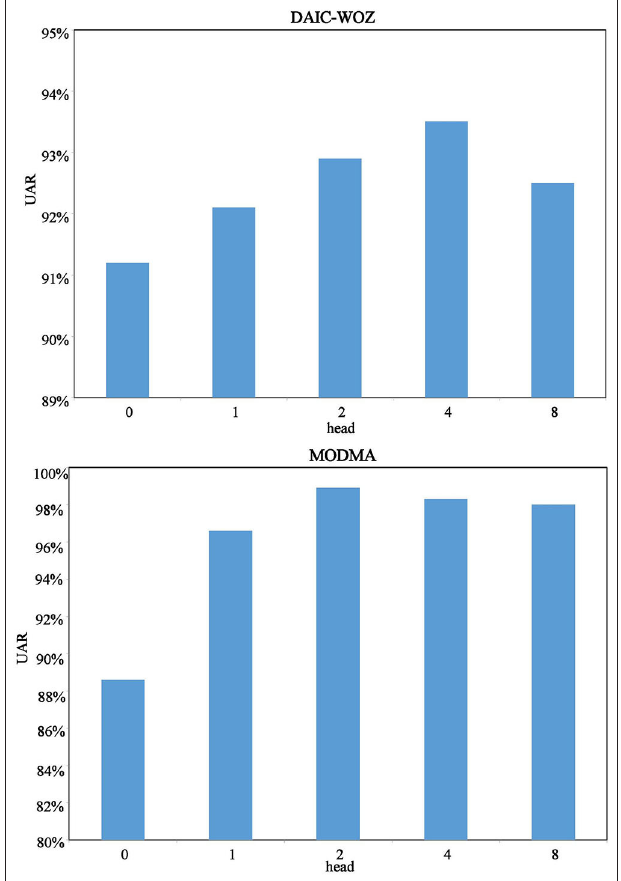
FIGURE 5 | Result tendency of different models on the DAIC-WOZ and MODMA